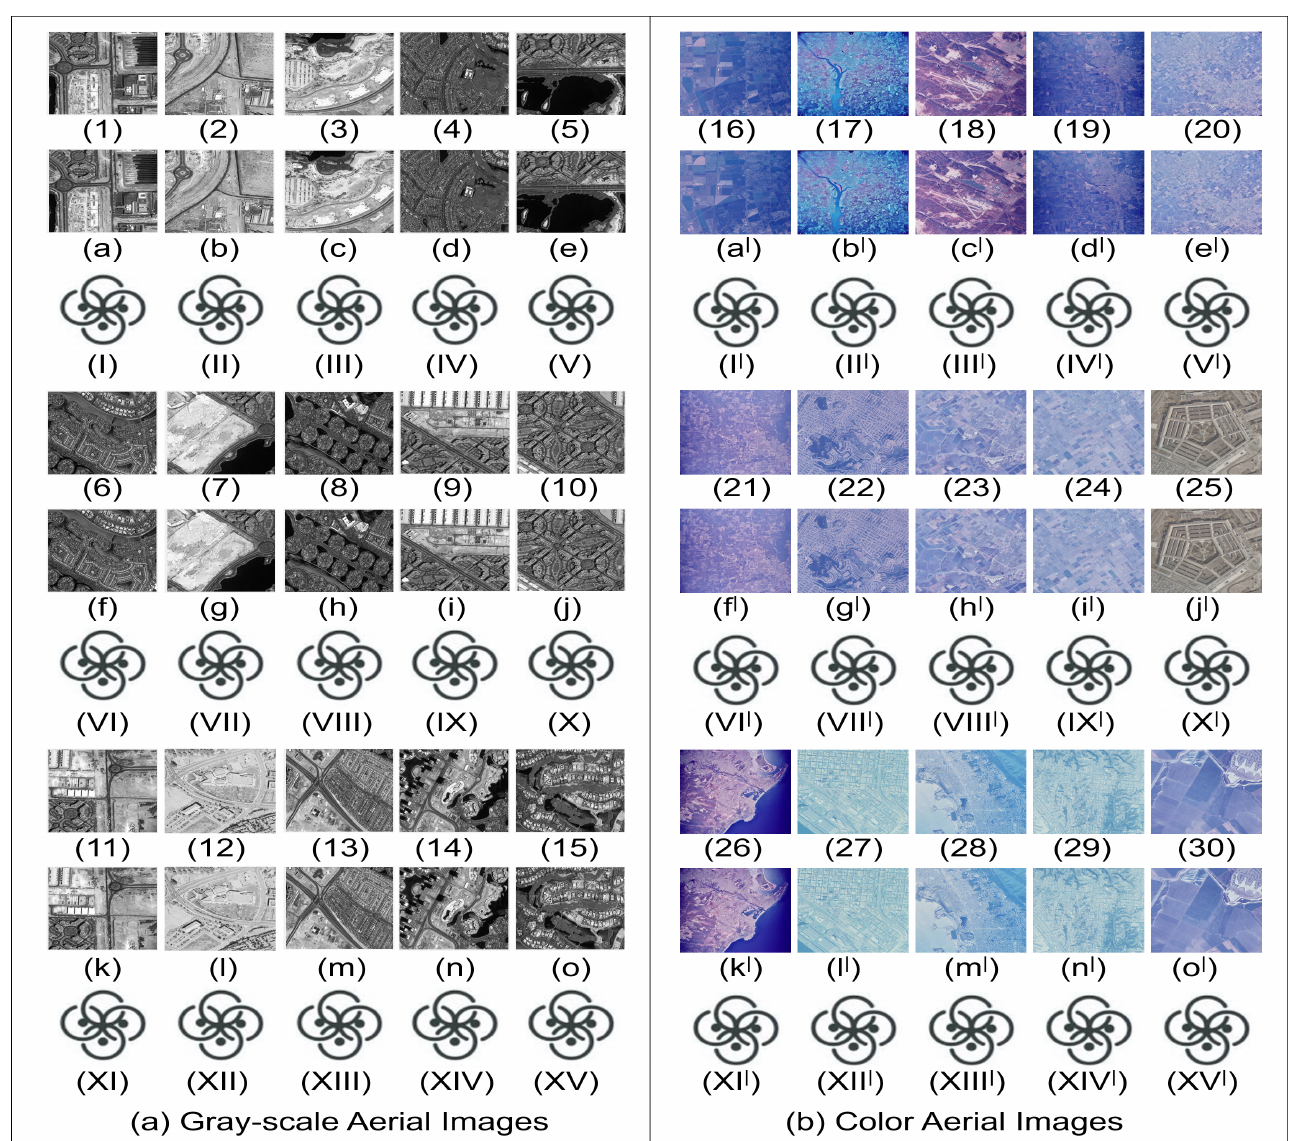
Figure 8. Aerial images (gray-scale images ( 1 – 15 ), color images ( 16 – 30 )) with corresponding wa- termarked images (gray-scale watermarked images ( a – o ), color watermarked images ( a 1 – o 1 )) and extracted watermark images ( I – XV , I 1 – XV 1